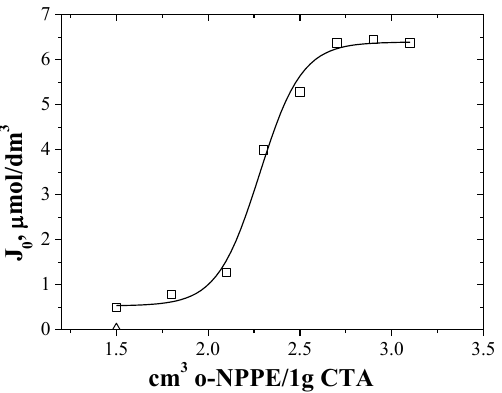
Figure 4. The effect of plasticizer in membranes on the Zn(II) ions initial fluxes during the transport across membrane doped with EDAB-acak.